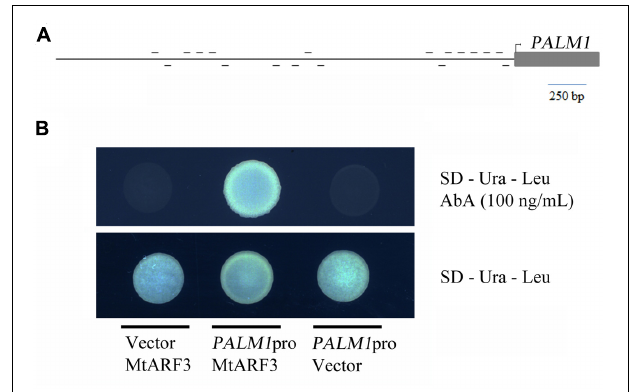
FIGURE 1 | Yeast one-hybrid assays of interactions between MtARF3 and the PALM1 promoter sequence. (A) A schematic drawing of the promoter and coding regions of PALM1. Short horizontal lines represent putative auxin response elements (AuxREs; TGTCxx) on the plus (above) and minus (beneath) strands of the promoter sequence. (B) Yeast one-hybrid assays, showing interactions between MtARF3 and the PALM1 promoter sequence. SD, synthetic drop-out media; Ura, uridine; Leu, leucine; AbA, aureobasidin